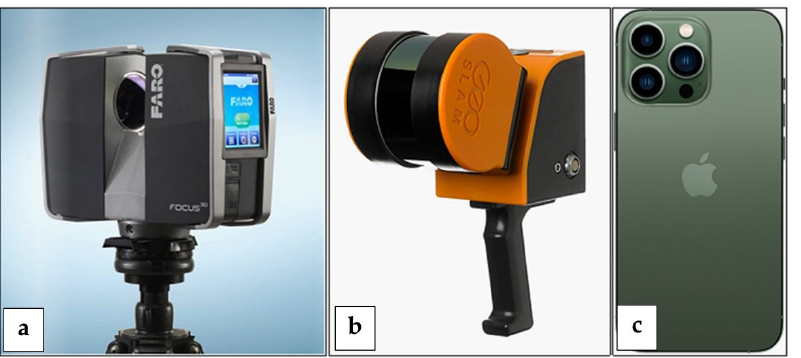
Table 1. Comparison of time required for data collection of all sections 450 m long of the forest road.